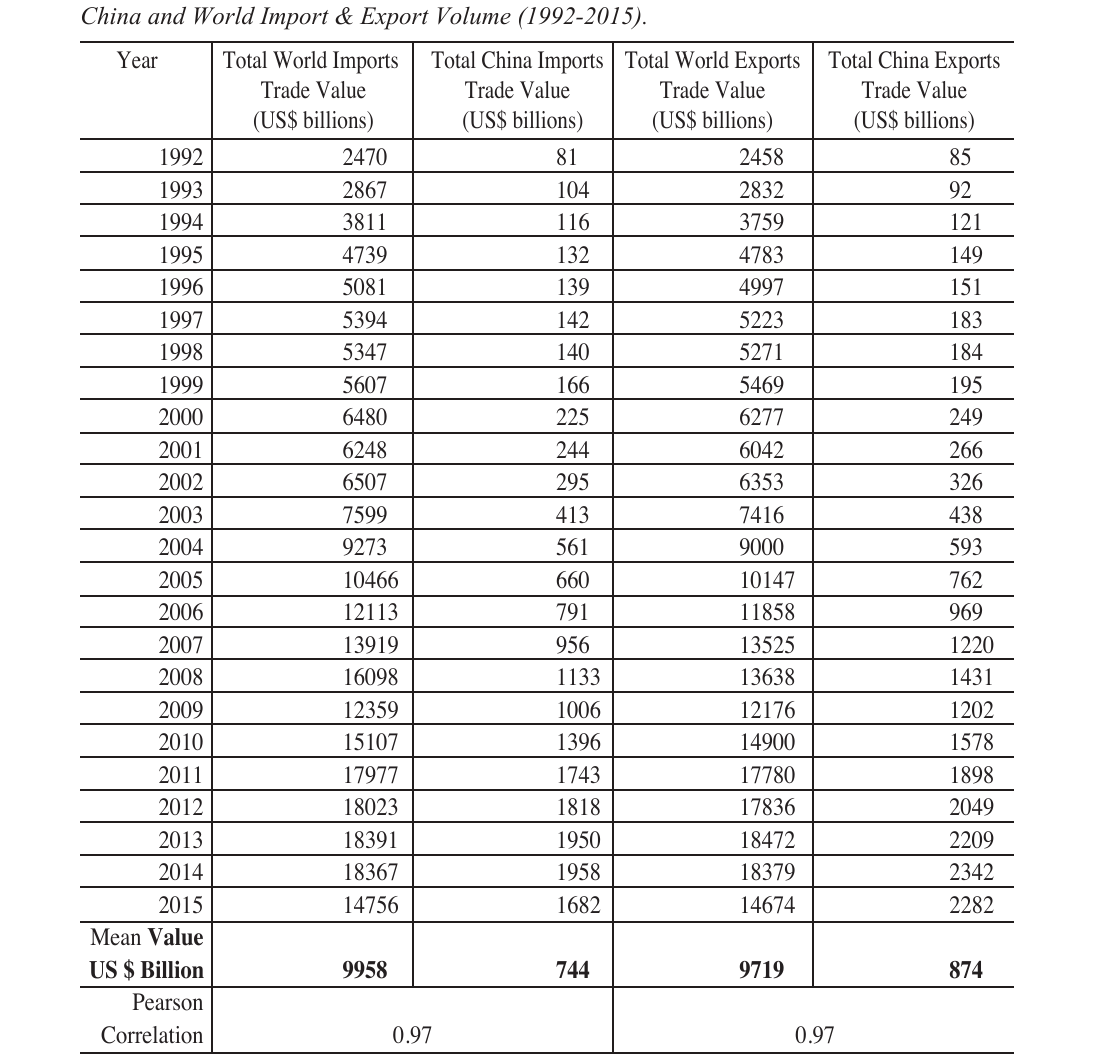
China and World Import & Export Volume